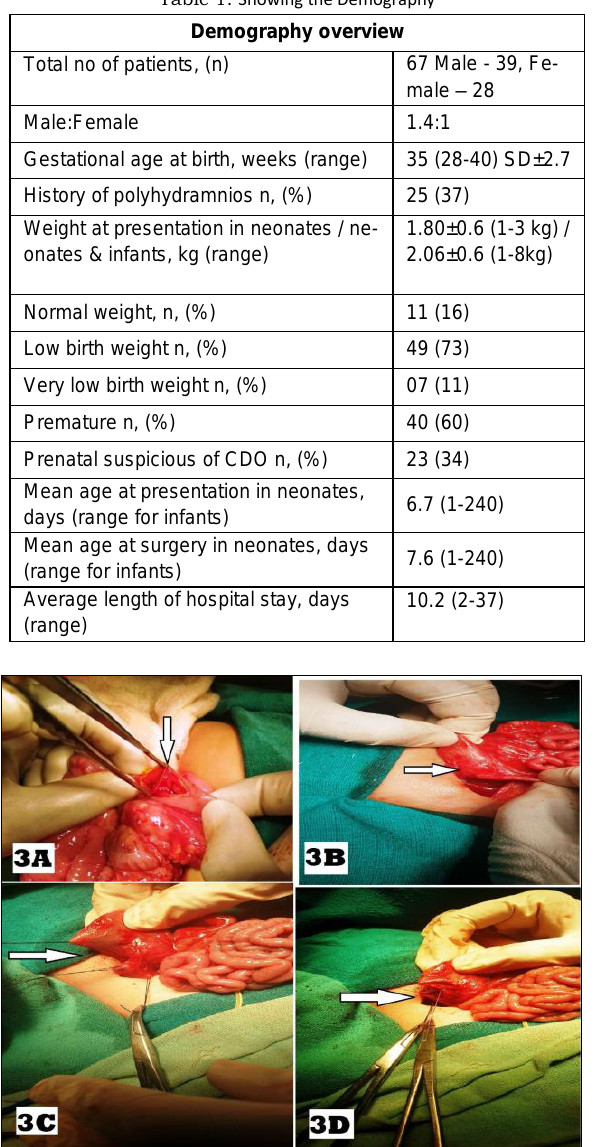
Figure 3. Different types of duodenal atresia. A) Duodenal web/ Type 1atresia with intact bowel wall and mesentery. B) Type 2 atresia- two ends connected by fibrous tissue in between without breach in the mesentery. C) Type 3 atre- sia – V- shaped mesenteric defect between blind ends. D) Kimura’s technique